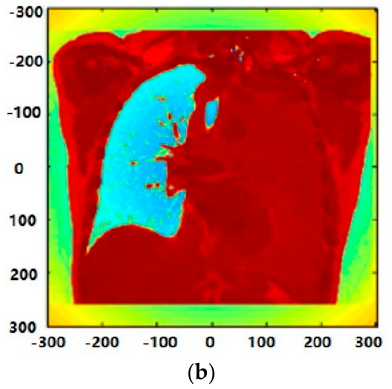
Figure 3. ( a ) Diagram of holographic electromagnetic induction (HEI) system; and ( b ) simulation result of lung phantom using the HEI system [120].